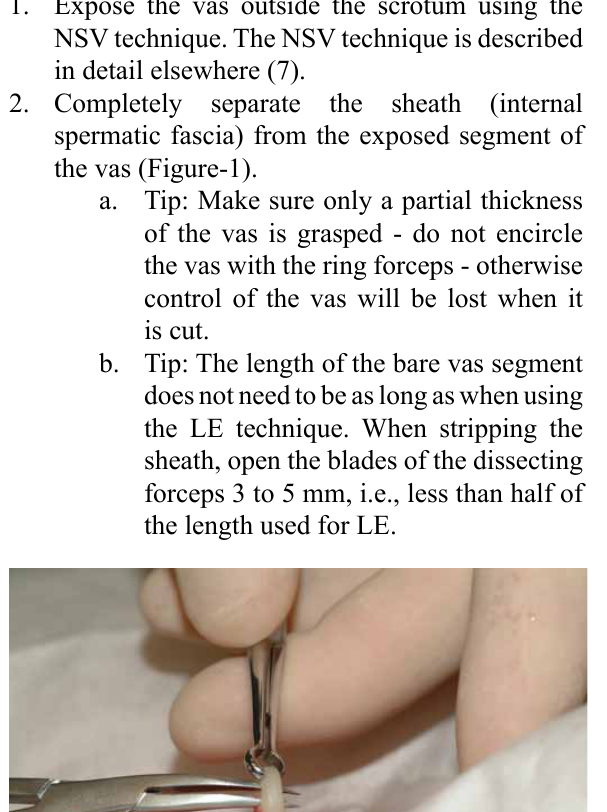
Figure 3 - Hemi-transecting the vas with a thermal cau- tery